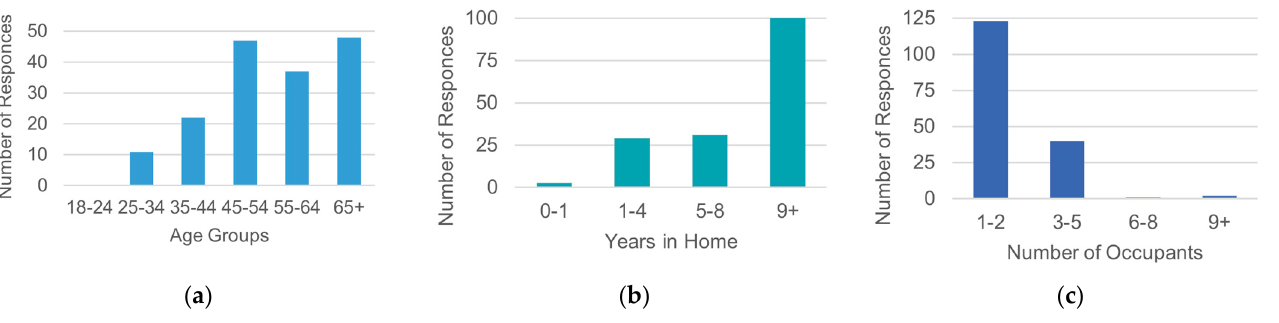
Figure 8. ( a ) The distribution of age groups of questionnaire respondents; ( b ) the number of years respondents have lived in their home; ( c ) the number of occupants that live within the home of respondents.